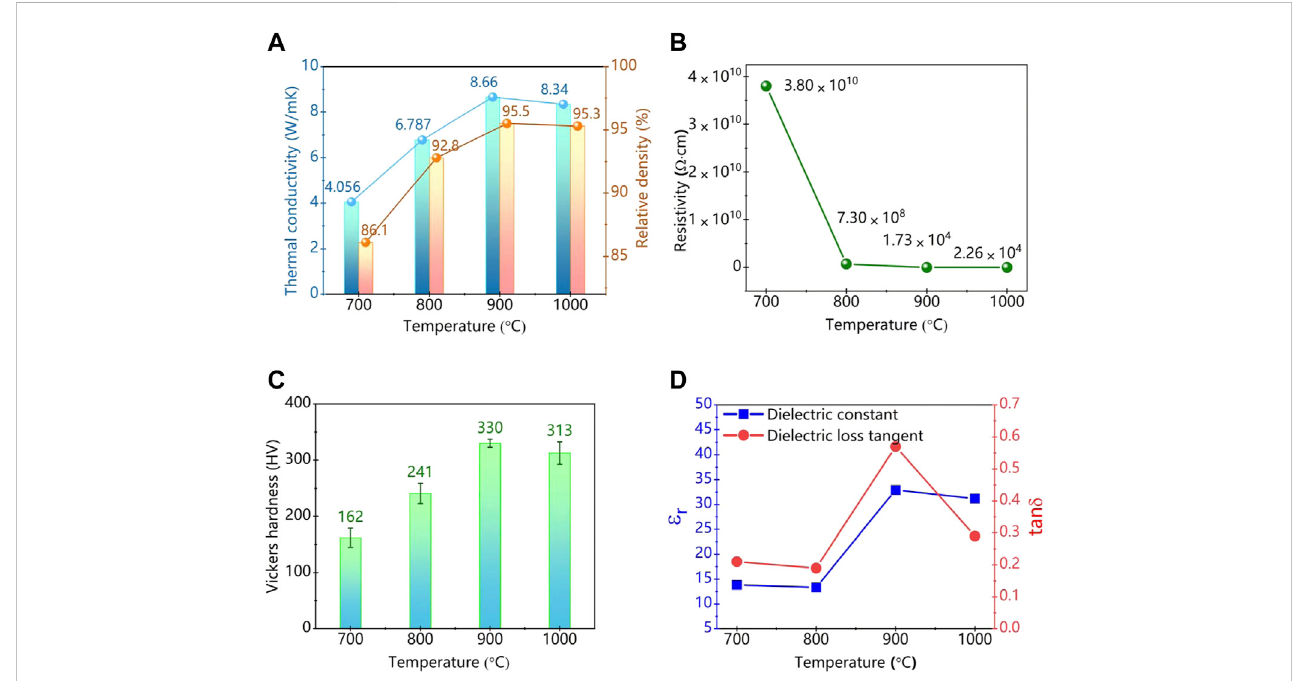
FIGURE 5 Thermal conductivity, resistivity, Vickers hardness, and dielectric properties of SiC/BBSZA composites sintered at different temperatures. (A) Thermal conductivityofSiC/BBSZAcompositeswithdifferentsinteringtemperatures; (B) DCresistivityofSiC/BBSZAcompositeswithdifferentsinteringtemperatures; (C) Vickers hardness of SiC/BBSZA composites with different sintering temperatures; (D) dielectric constant and dielectric loss tangent of SiC/BBSZA composites with different sintering